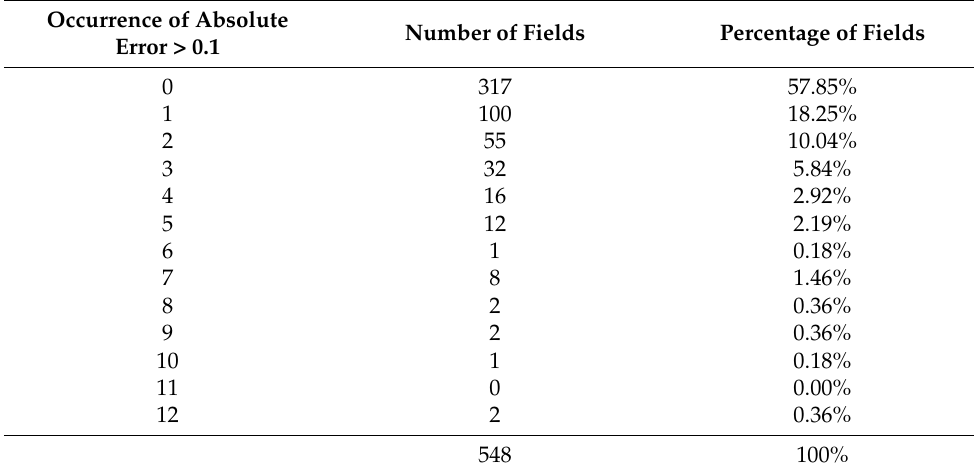
Table 3. Occurrences of an absolute error > 0.1 for all fields.